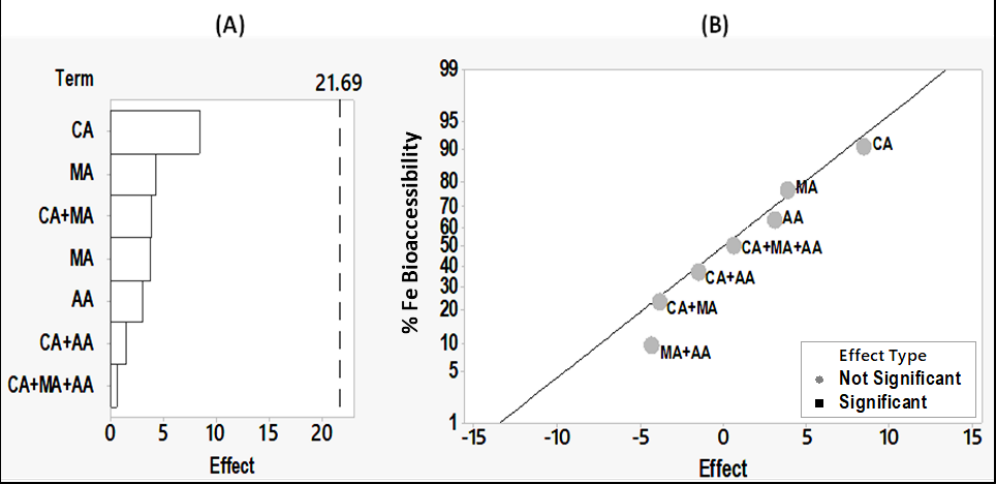
Figure 5. Pareto chart ( A ) and the Normal plot ( B ) of the effects of each acid added alone or in combination, on iron bioaccessibility in the HDA samples according to the 2 3 experimental design (full factorial, α = 0.05). (HDA: hummus with different acids). CA: citric acid, MA: malic acid, AA: ascorbic acid. Each acid is at 4 mmol/100 g of ChpTG.